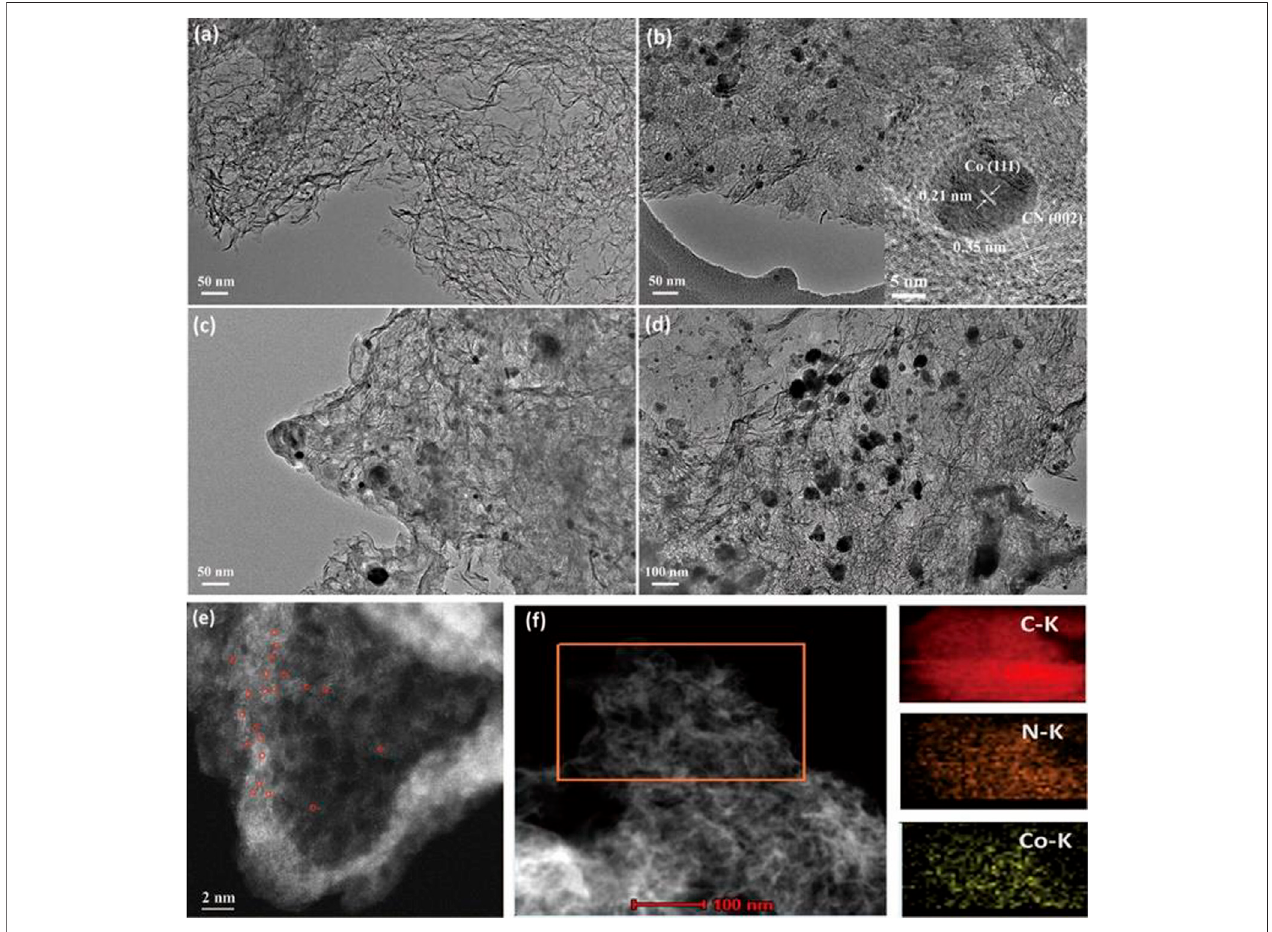
FIGURE 1 | TEM images of the Co-N-C X catalysts: (A) Co-N-C 0.0125M , (B) Co-N-C 0.025M (Inset: HRTEM image of Co-N-C 0.025M ). (C) Co-N-C 0.05M and (D) Co-N- C 0.075M . (E) HAADF-STEM image of Co-N-C 0.0125M . (F) STEM image and corresponding element mapping of Co-N-C 0.025M